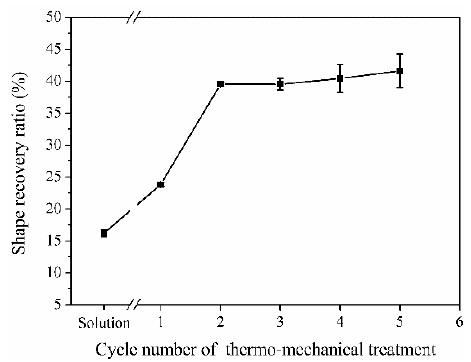
Figure 2. Effect of thermomechanical cycle number on shape recovery ratio for specimens after being bent by 2.5% at 77 K and then directly heated at 1073 K. Each thermomechanical cycle consists of 13% tensile strain at RT and subsequent annealing at 833 K.